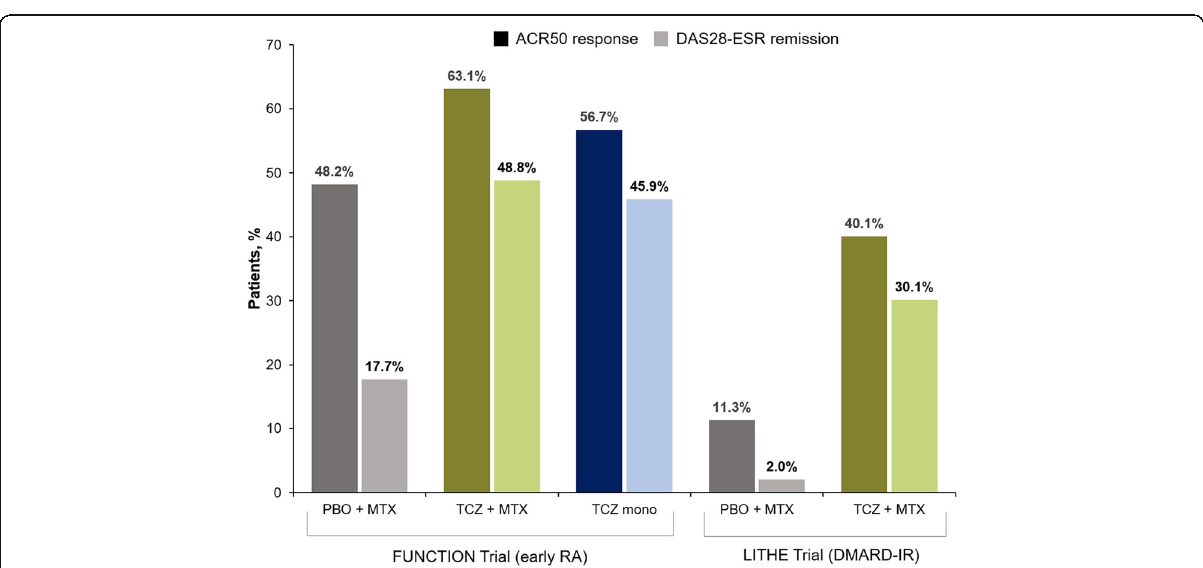
Fig. 2 Proportion of Patients Who Achieved ACR50 Response and DAS28-ESR Remission at Week 24 by Study and Treatment Arm. ACR50, 50% improvement per the American College of Rheumatology; DAS28-ESR, Disease Activity Score in 28 joints calculated with erythrocyte sedimentation rate; DMARD-IR, inadequate response to disease-modifying antirheumatic drugs; mono, monotherapy; MTX, methotrexate; PBO, placebo; RA, rheumatoid arthritis; TCZ,